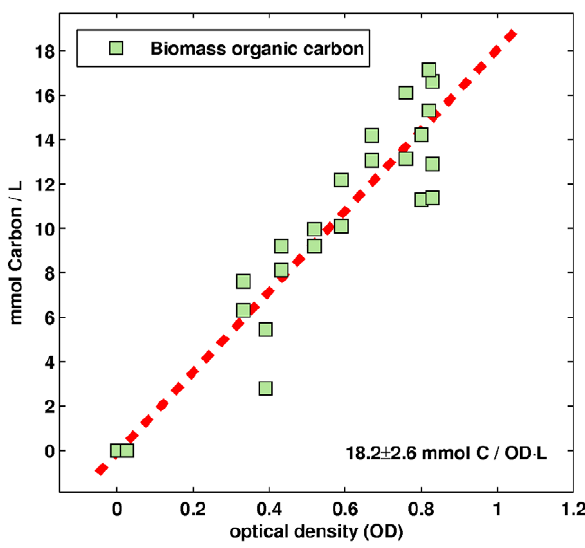
Figure 2. Biomass total organic carbon content. The total organic carbon content of the biomass was measured at different optical densities. We calculated a linear correlation of 18.2 + 2.6 mmol of carbon per OD : L. This value was used to formulate the growth function used for flux balance analysis (see text for details).